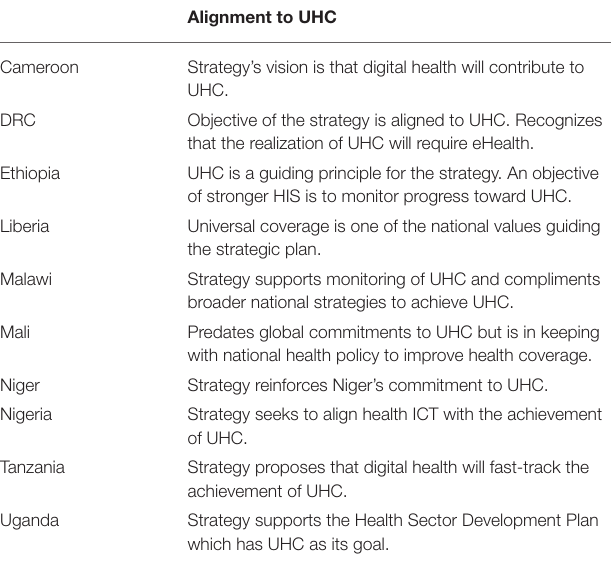
TABLE 5 | Strategy alignment to UHC.